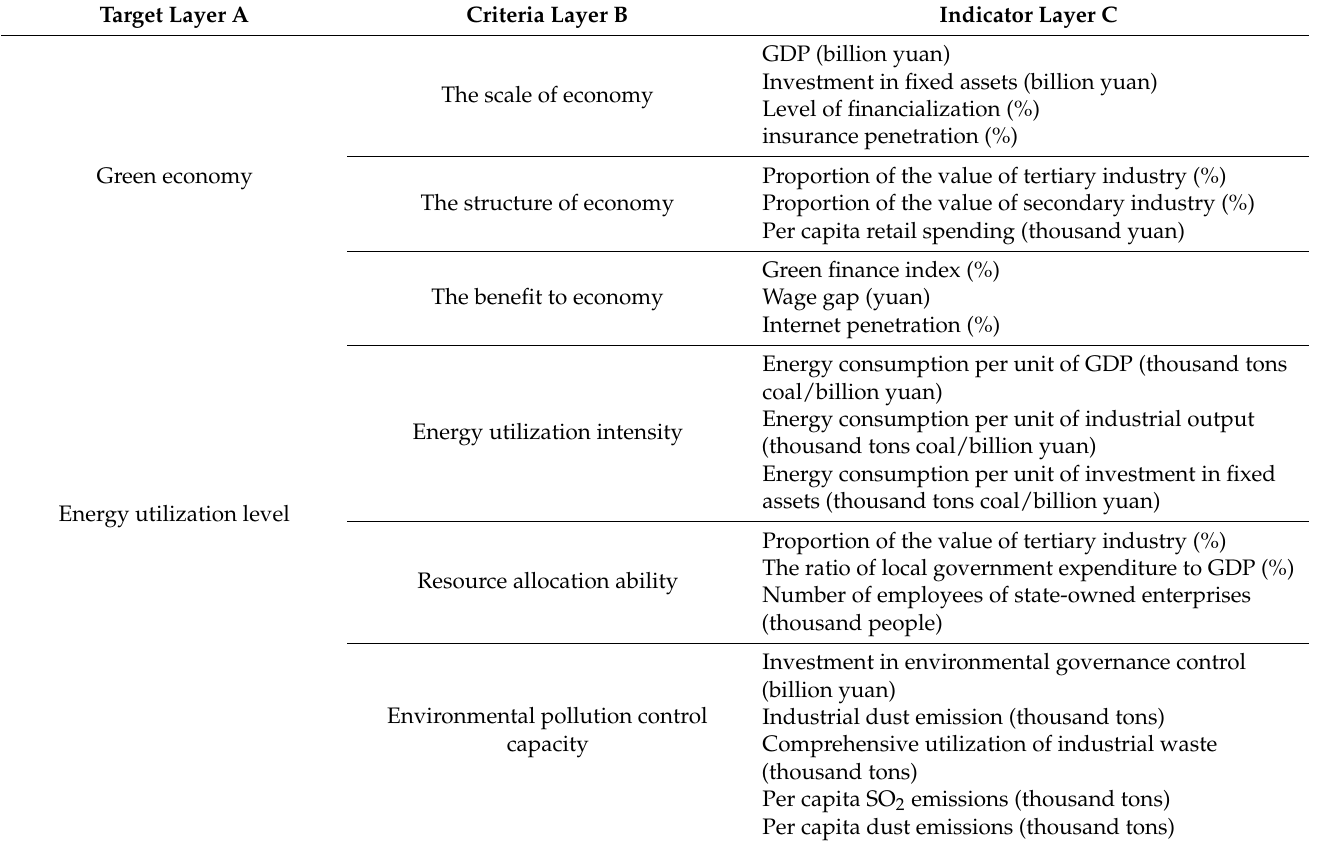
Table 1. The index system of green economy and energy utilization